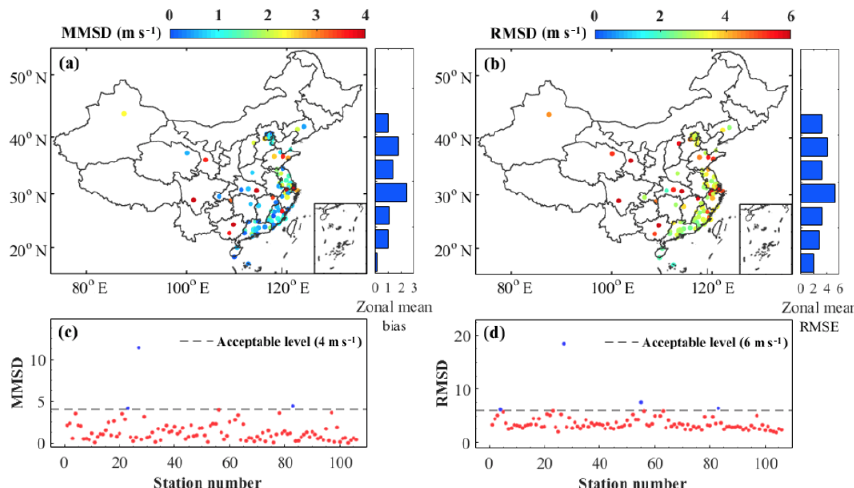
Figure 7. Spatial distribution of (a) the magnitude of the mean speed difference (MMSD) and (b) the root-mean-square difference (RMSD) at each station during November 2018 to March 2019; the corresponding histogram represents the average difference in zonal direction; (c) and (d) are corresponding recommended (red dots) and non-recommended (blue dots) sites for (a) and (b) , respectively. The MMSD and REMD at each station were derived from the measurements over all levels from 0 to 3km.